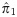
QQ plots of (pruned) z-scores for qualitative phenotypes (dark blue, 95% confidence interval in light blue) with model prediction (yellow): (A) major depressive disorder; (B) bipolar disorder; (C) schizophrenia; (D) coronary artery disease (CAD); (E) ulcerative colitis (UC); (F) Crohn’s disease (CD); (G) late onset Alzheimer’s disease (AD), excluding APOE (see also S1 Appendix (p. S17)); and (H) amyotrophic lateral sclerosis (ALS), restricted to chromosome 9 (see also S1 Appendix (p. S18)).The dashed line is the expected QQ plot under null (no SNPs associated with the phenotype). p is a nominal p-value for z-scores, and q is the proportion of z-scores with p-values exceeding that threshold. λ is the overall nominal genomic control factor for the pruned data (which is accurately predicted by the model in all cases). The three estimated model parameters are: polygenicity, π^1; discoverability, σ^β2 (corrected for inflation); and SNP association χ2-statistic inflation factor, σ^02. h^2 is the estimated narrow-sense chip heritability, re-expressed as hl2 on the liability scale for these case-control conditions assuming a prevalence of: MDD 7.1% [57], BIP 0.5% [58], SCZ 1% [59], CAD 3% [60], UC 0.1% [61], CD 0.1% [61], AD 14% (for people aged 71 and older in the USA [62, 63]), and ALS 5 × 10−5 [64]. The estimated number of causal SNPs is given by n^causal=π^1nsnp where nsnp = 11, 015, 833 is the total number of SNPs, whose LD structure and MAF underlie the model; the GWAS z-scores are for subsets of these SNPs. Neff is the effective case-control sample size–see text. Reading the plots: on the vertical axis, choose a p-value threshold (more extreme values are further from the origin), then the horizontal axis gives the proportion of SNPs exceeding that threshold (higher proportions are closer to the origin). Numerical values for the model parameters are also given in Table 2. See also S1 Appendix (pp. S20-S28).